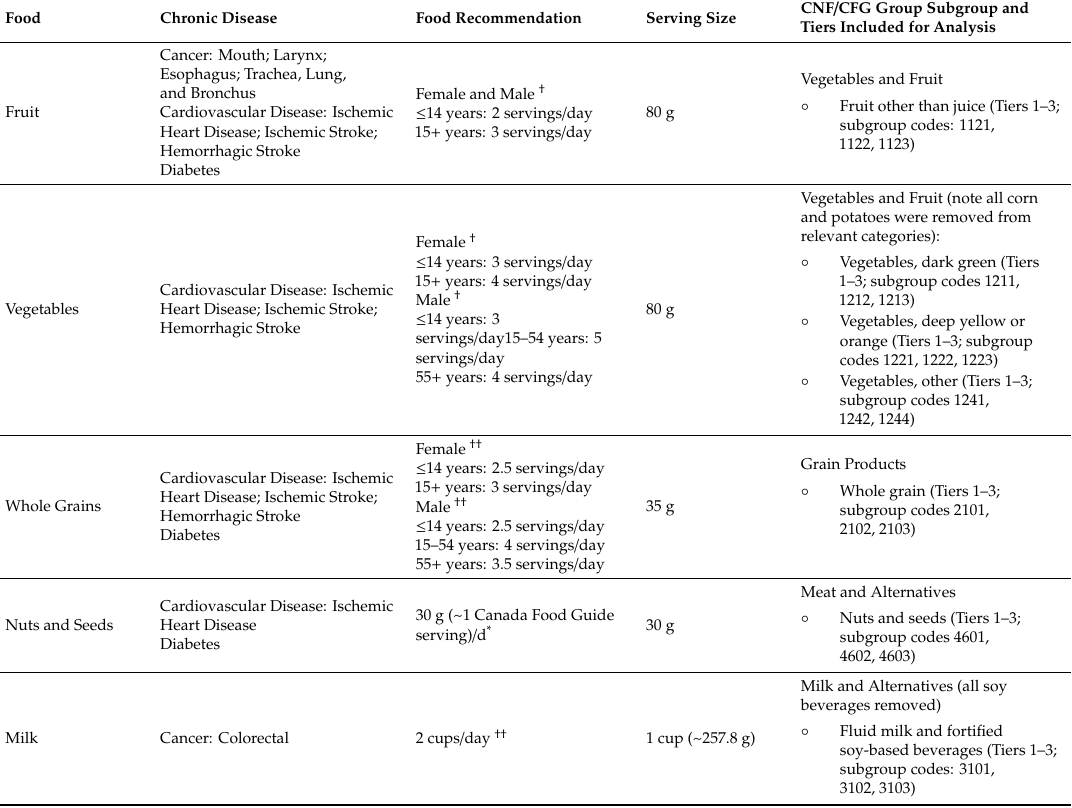
Table 1. Foods and chronic diseases included in estimation of the economic burden of unhealthy eating in